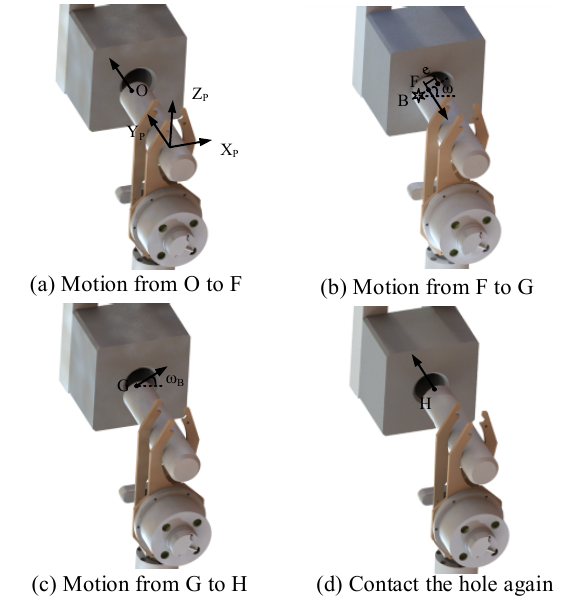
Figure 10. The movement of the peg when the peg contacts the surface of the hole.